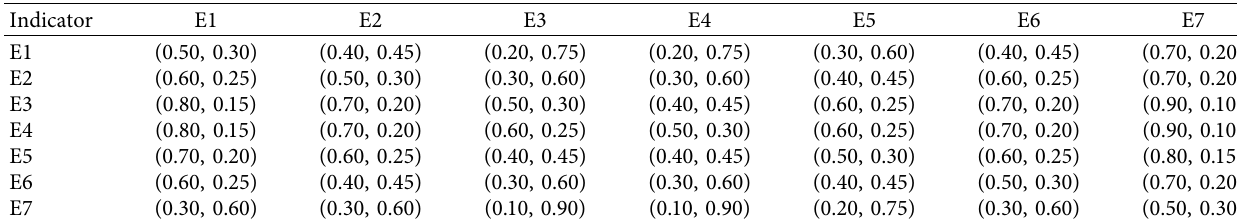
Table 5: Comparative results of the importance of the evaluation